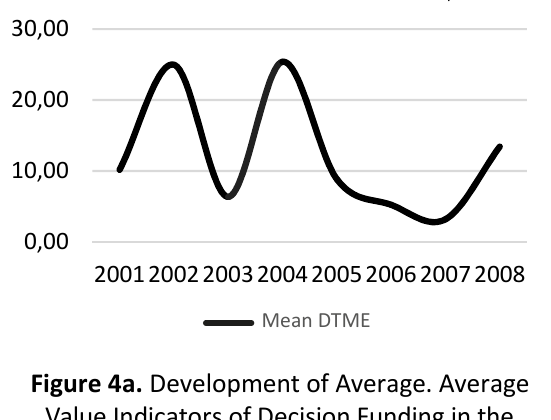
Figure 4a. Development of Average.